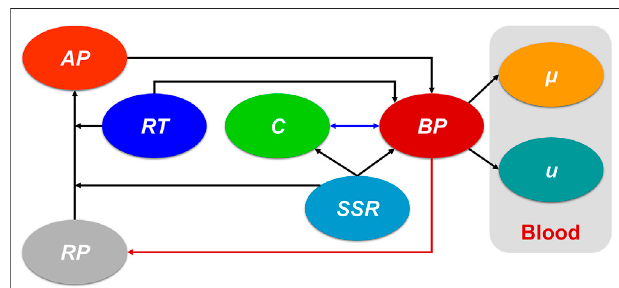
FIGURE 1 | The connections of the main variables in the present hemodynamics-based thrombosis model. The dark blue double arrow line indicates the interaction between the C and BP . The dark red arrow line denotes the consumption of platelets during thrombosis. AP : activated platelet, RP : resting platelet, RT : residence time, C : coagulant, SSR : shear strain rate, BP : bound platelets, μ and u is the viscosity and velocity of the blood,